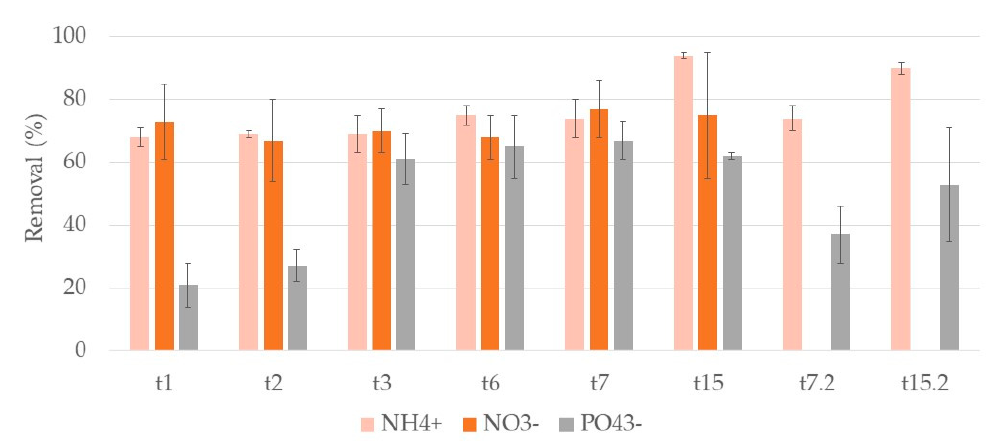
Figure 10. Removal percentage and respective standard deviation ( n = 3) for each nutrient ion, in CWs with lava rock (L) and T. latifolia during the two cycles of treatment. First cycle: samples taken after one day (t1), two days (t2), three days (t3), five days (t5), six days (t6), seven days (t7) and at the end of the two-week cycle (t15). Second cycle: samples taken after one week (t7.2) and at the end of the two-week cycle (t15.2) of treatment.